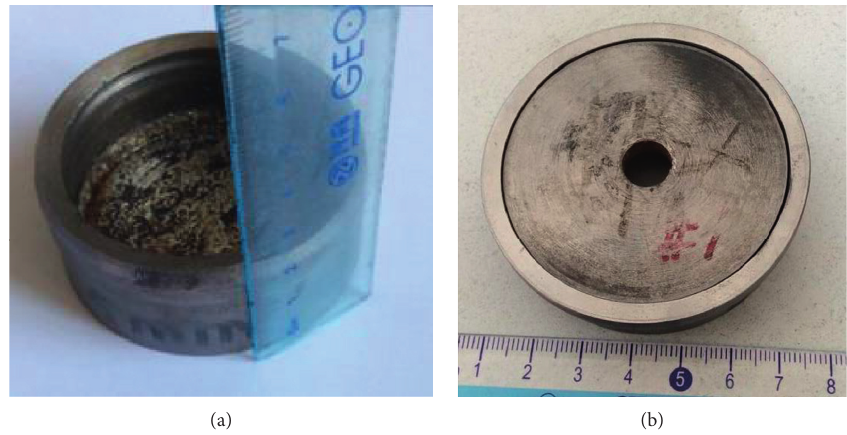
Figure 14: Buffers after the penetration: (a) buffer No. 1; (b) buffer No.